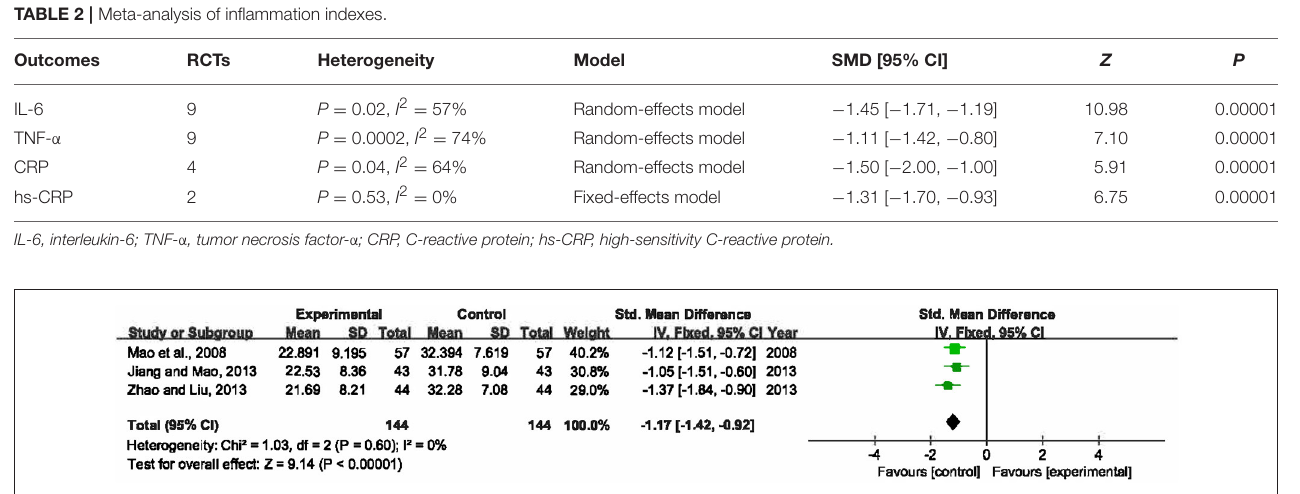
FIGURE 8 | Forest plot of LPS improvement in sepsis patients treated with XBJ + UTI therapy and UTI alone.